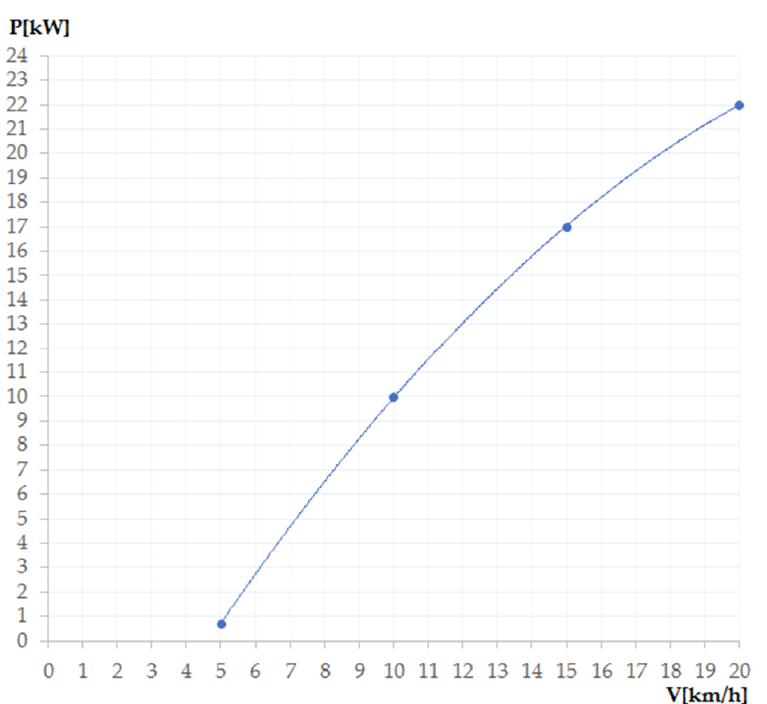
Figure 11. Power of auxiliary devices supplied from DC links as a function of speed at a traction inverter DC link capacitance of 10 mF.